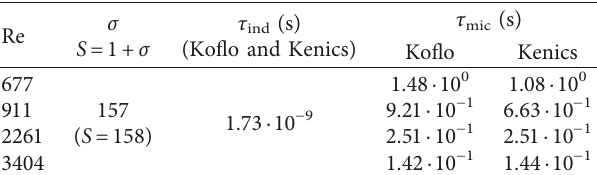
Figure 15: The energy dissipation rate ε in the Koflo static mixer (Re Table 5: The comparison of the induction and micromixing times.